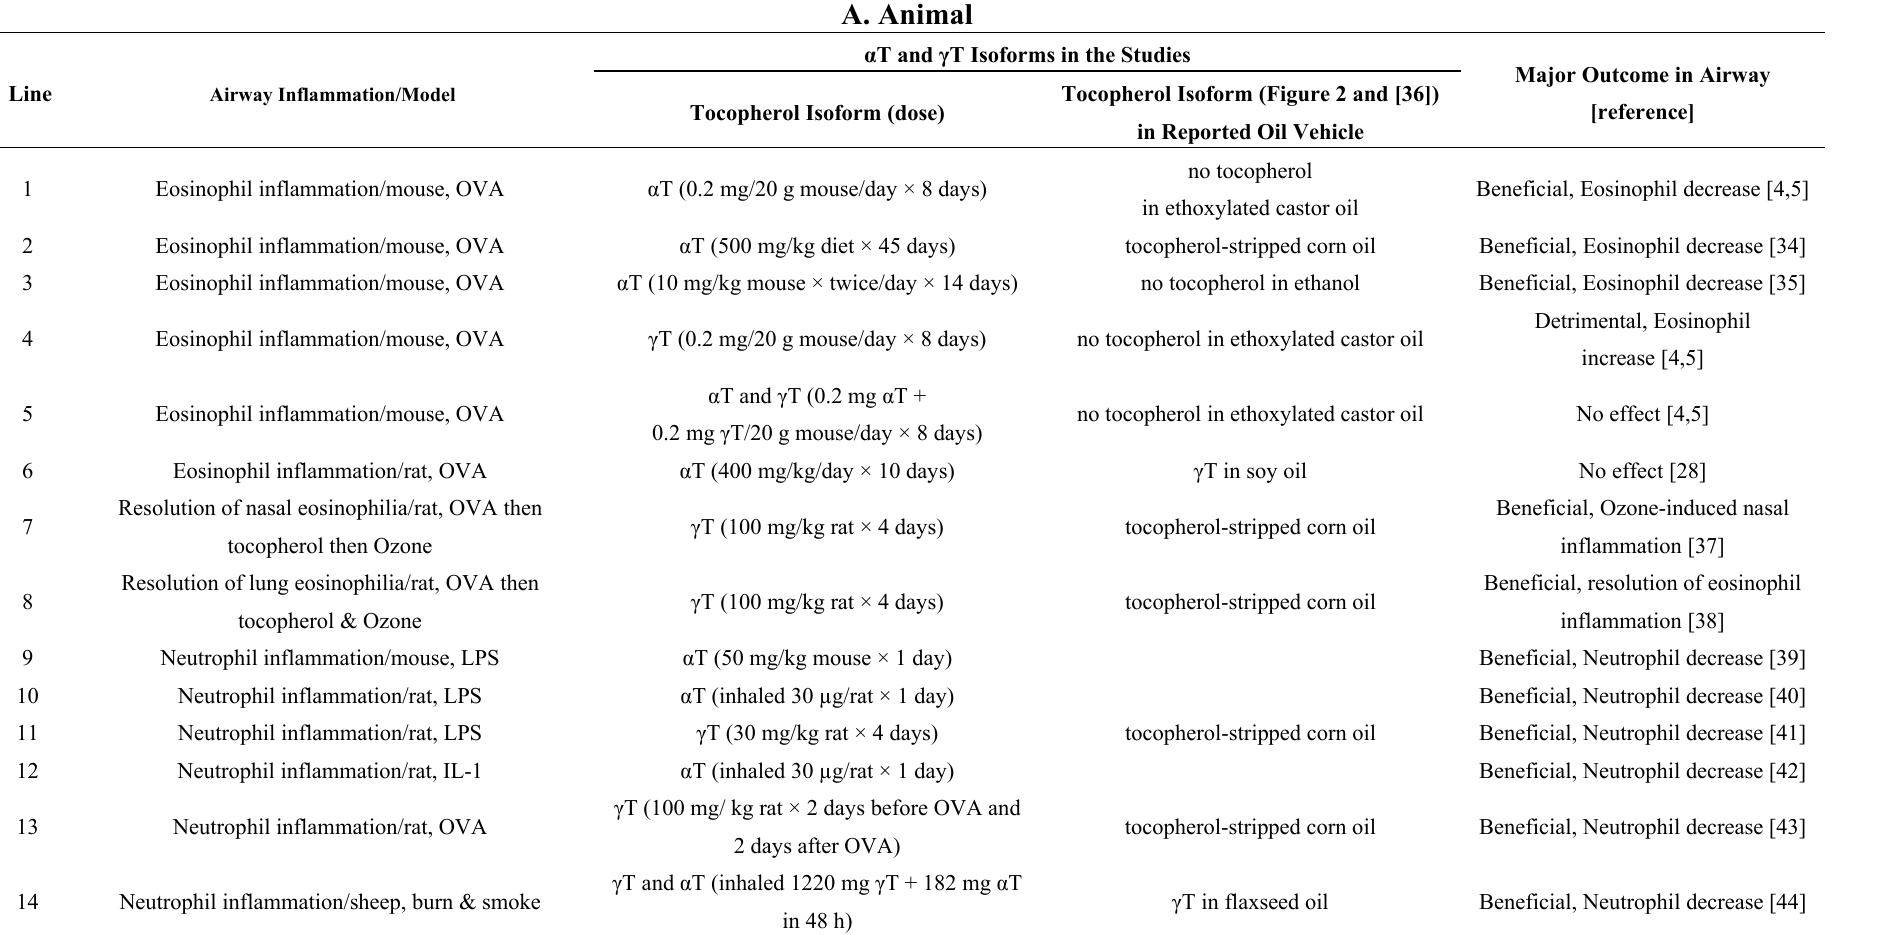
Table 1. α -Tocopherol ( α T) and γ -tocopherol ( γ T) isoforms in lung studies. A.